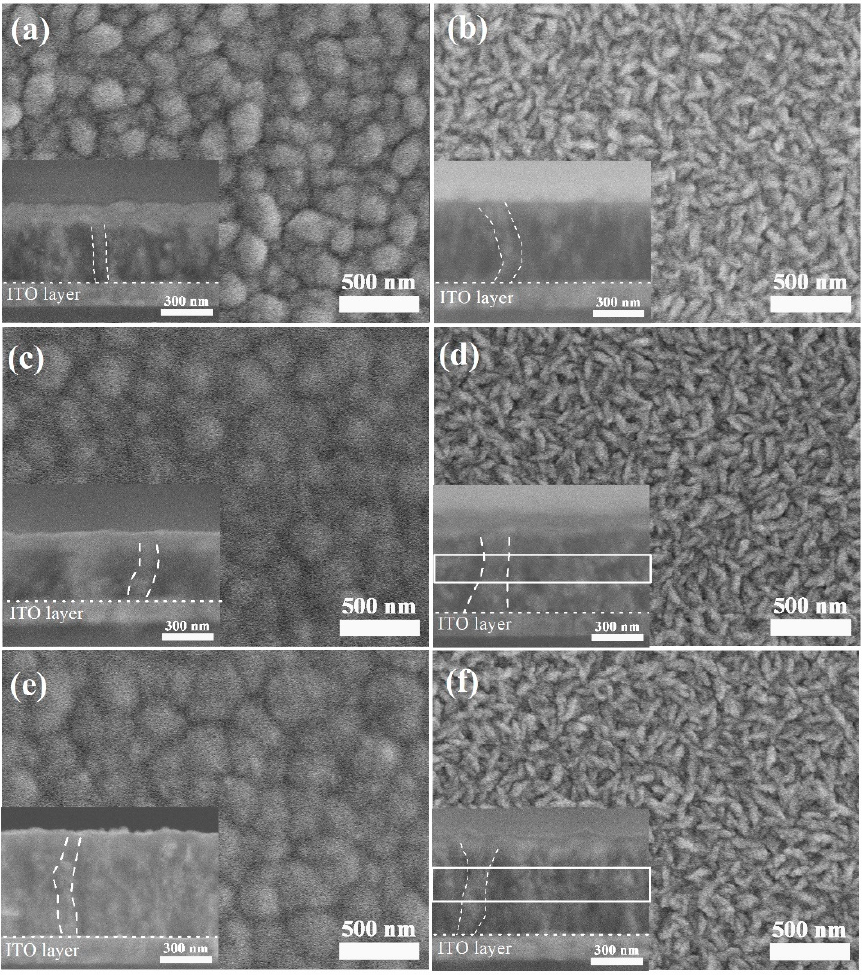
Figure 2. SEM image of SA1 ( a ), SA2 ( b ), SB1 ( c ), SB2 ( d ), SC1 ( e ), and SC2 ( f ). The insets show SEM cross-sectional images of the